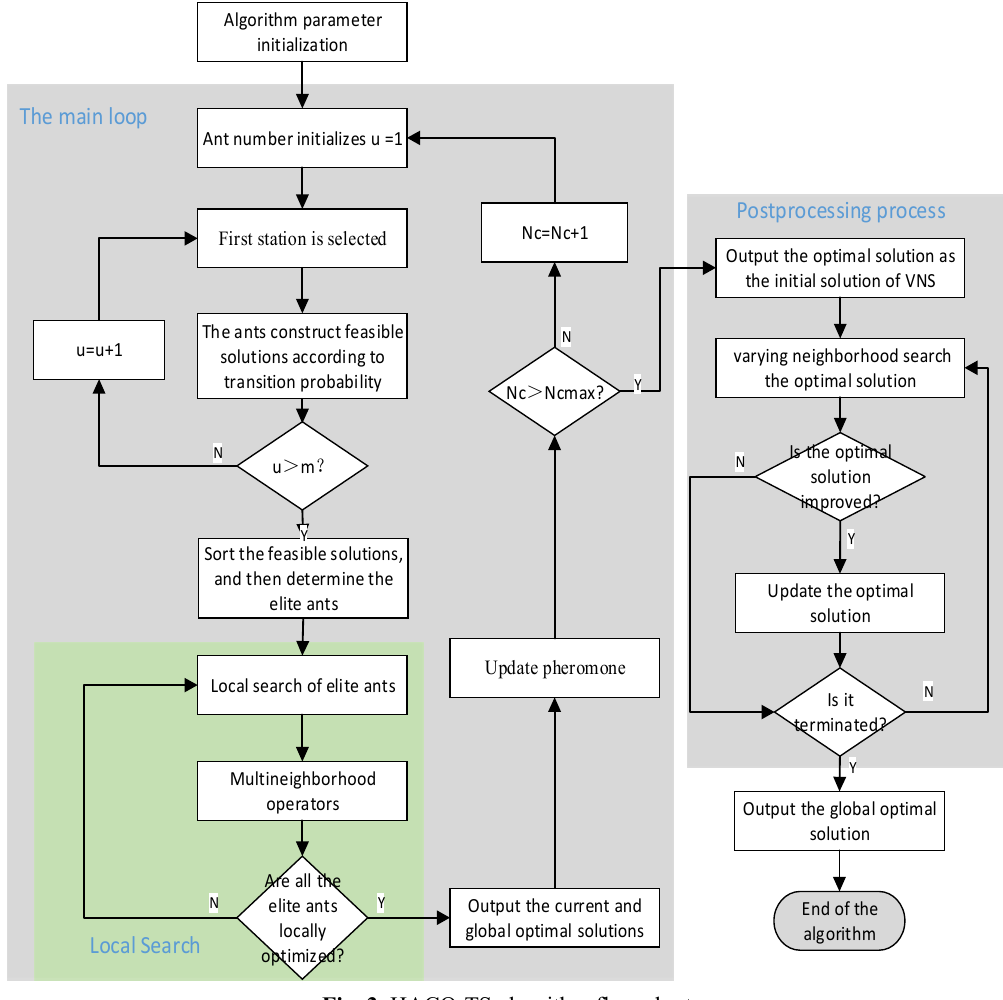
Fig. 3. HACO-TS algorithm flow